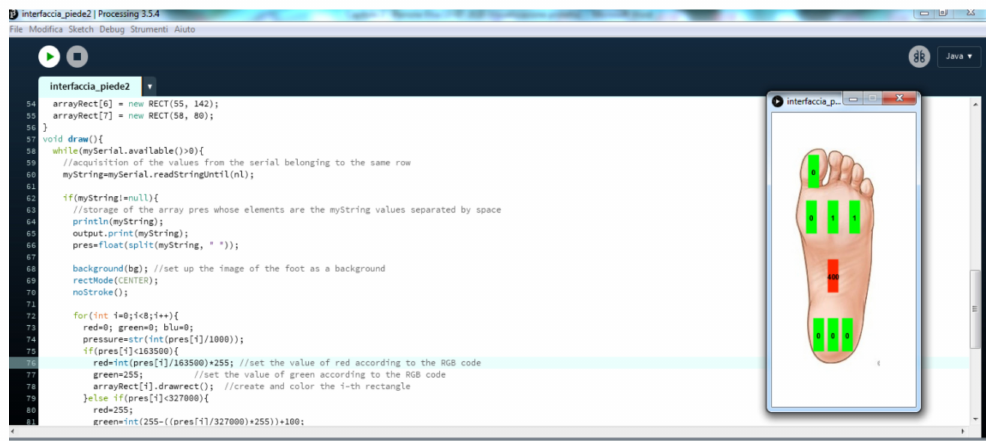
Figure 25. Graphical interface realized with Processing ® for displaying the incoming pressure data in the form of a color